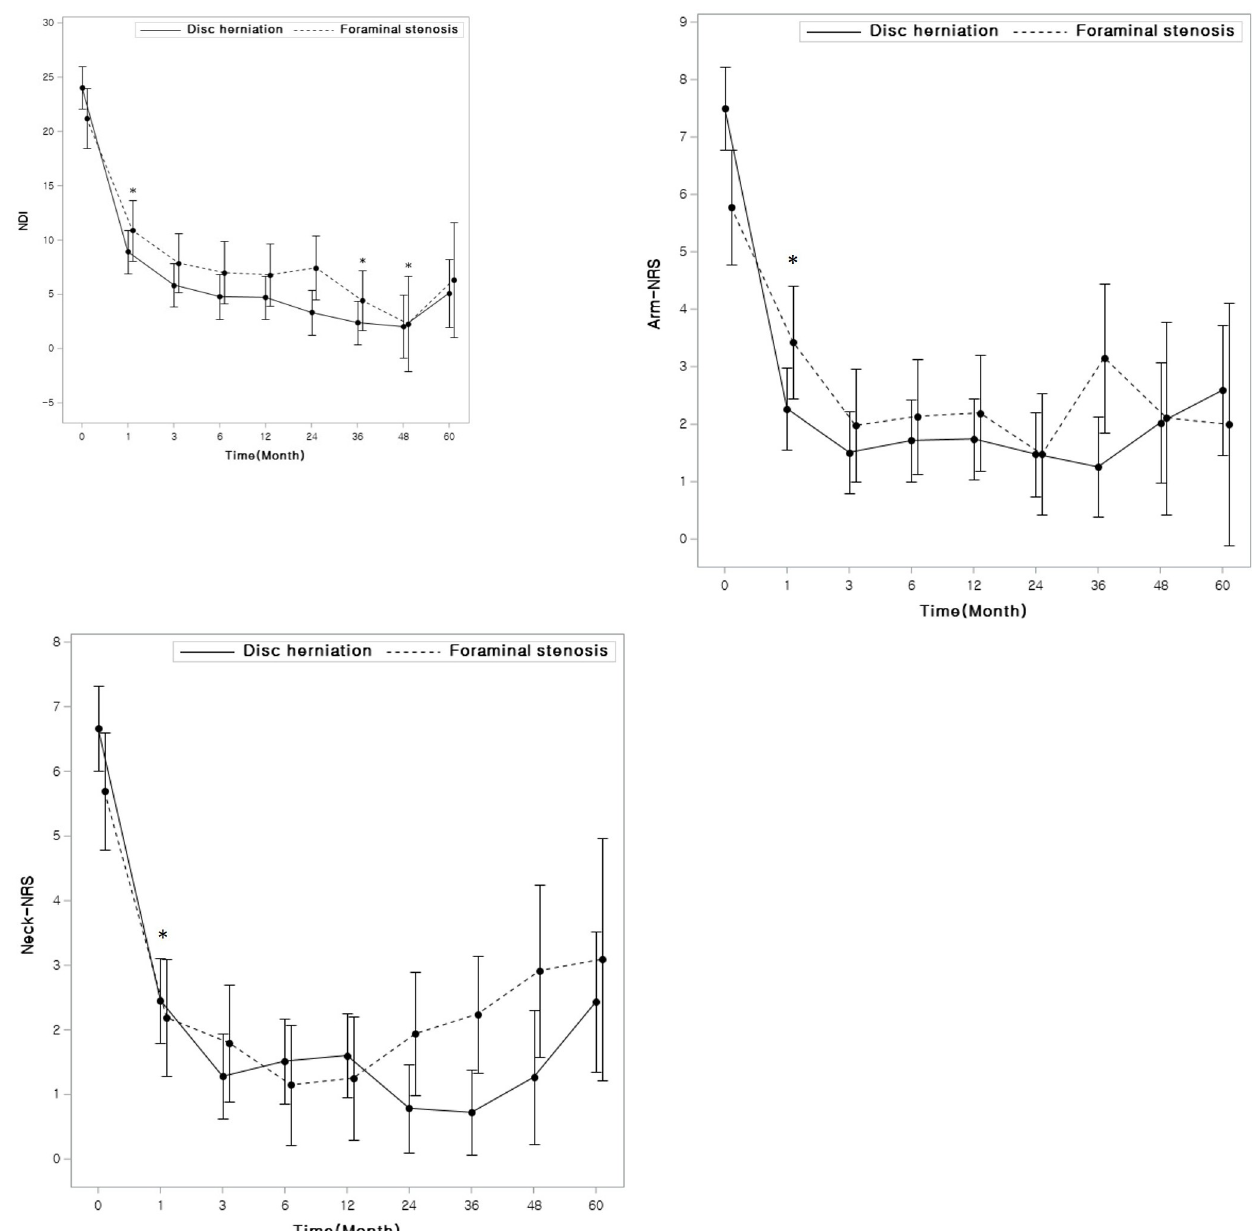
Fig 2. Adjusted mean values from the mixed-effects model for clinical outcomes. The Neck Disability Index (NDI) and numerical rating scale from 0 (no pain) to 10 (most severe pain) for neck pain (Neck-NRS) and arm pain (Arm-NRS) are presented as line graphs. Time 0 represents the preoperative score. An asterisk represents a statistically significant difference starting at 3 months after the